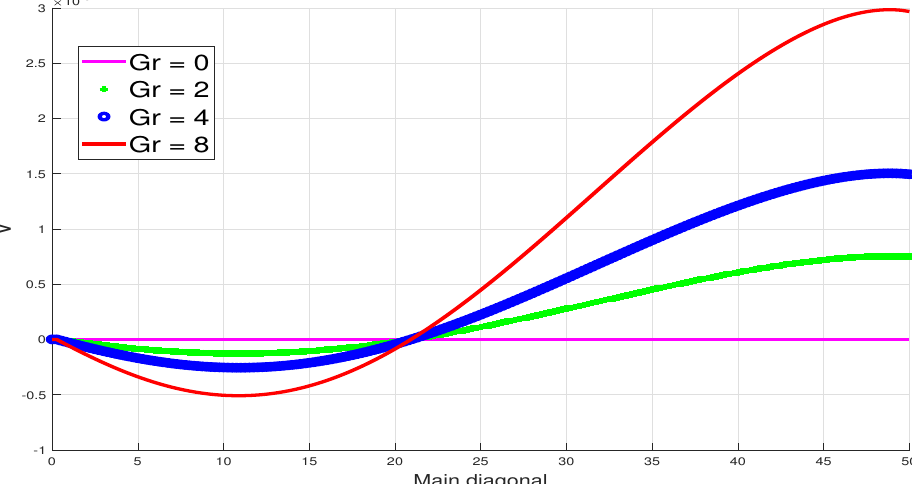
Figure 20. Axial velocity dependence on Gr at t = 5.